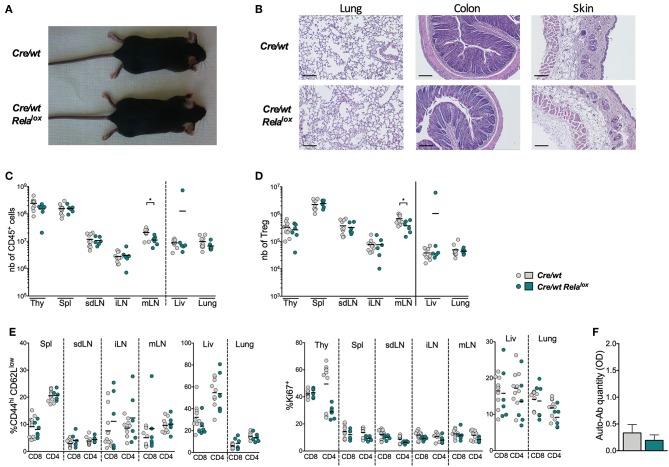
Heterozygous Foxp3Cre/wt
Relalox do not develop systemic inflammation. (A) Representative pictures of 8 week-old mice. (B) Representative histology of lung, colon and skin of 8 week-old. Scale bars represent 100 μm. Number of CD45+
(C), of Tregs among CD4+ T cells (D), and proportion of CD44hiCD62Llow and Ki67+ among CD8+ and CD4+ conventional T cells (E) in different tissues (thy, thymus; spl, spleen; liv, liver; SI, small intestine) of 8 week-old Foxp3Cre/wt (Cre/wt) and Foxp3Cre/wt
Relalox (Cre/wt Relalox) mice. Each dot represents a mouse and lines show the means of pooled independent experiments. (F) Anti-DNA auto-antibodies quantification in the serum of 8 week-old Foxp3Cre/wt and Foxp3Cre/wt
Relalox mice. Bars show the means of pooled independent experiments and error bars represent SEM. For mouse and experiment numbers, see Supplementary Table 1. The two-tailed unpaired non-parametric Mann–Whitney U test was used *p < 0.05.